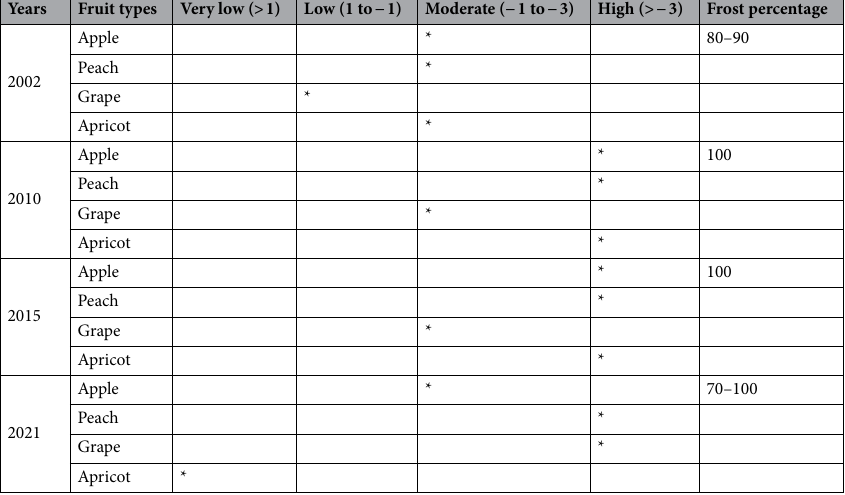
Table 7. Frost resistance in Celsius degrees (°C) for each garden products generated using The Zonal Statistics Table tool and their predicated damages.